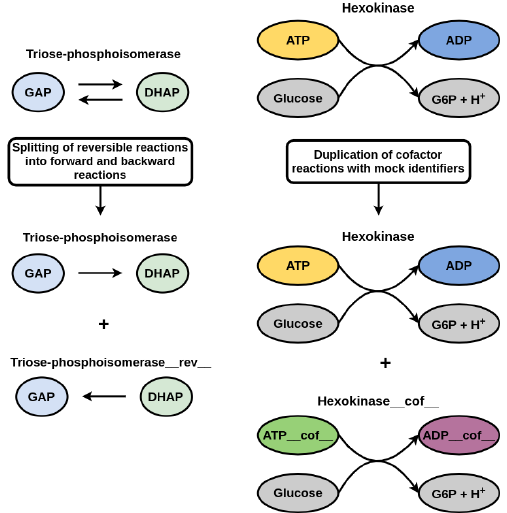
Figure 3. Topological network modifications moped offers functions for splitting reversible reactions into forward and backward reactions in a network. Adding a copy of each cofactor dependent reaction and replacing cofactors (here ATP and ADP) with mock identifiers allows unblocking cofactor dependent reactions while avoiding degradation products of cofactors contained in the seed. Such modifications enable biologically feasible metabolic network